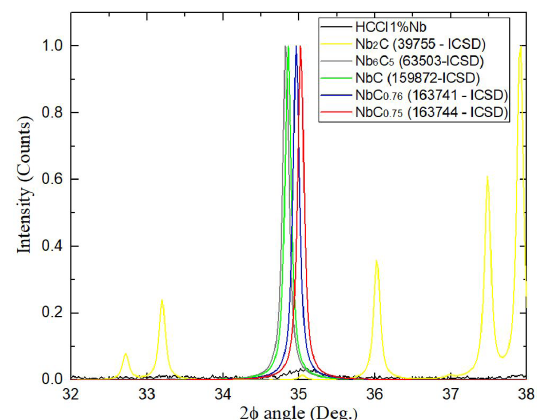
XRD peak and BDEC – ICSD files stoichiometry x